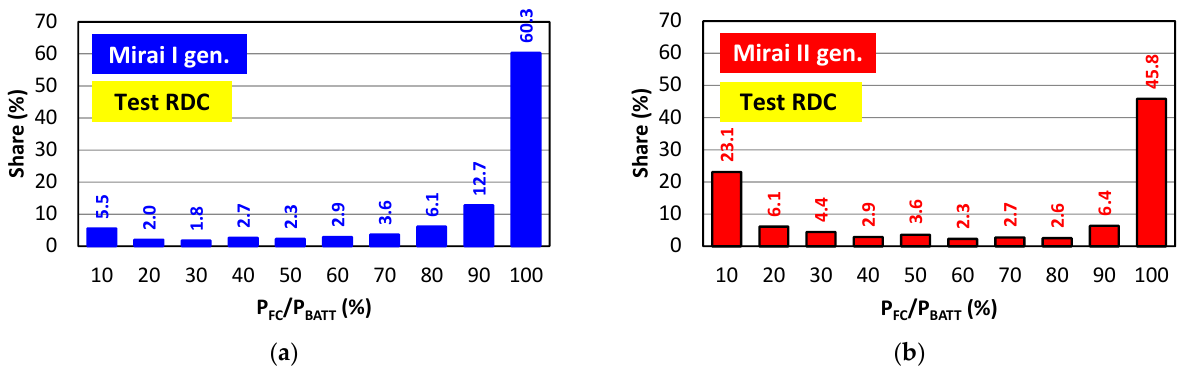
Figure 13. Fuel cell stack power and speed profiles in the RDC test: ( a ) I generation HFCHEV drive; ( b ) II generation FCHEV drive. The average fuel cell power values in the first-generation Toyota Mirai were 26% greater than the average values of the second-generation Mirai. Similarly, greater powers occurred in the rural phase of the driving test (by 35%). The motorway phase was characterized by the greater average power of the second-generation Mirai vehicle. The greater cell power was partly responsible for the observed operating conditions, but also the batteries, also with a higher power in the second generation system. Analysis of the share of the cell’s power in relation to the battery’s power was presented in Figure 14. The data analysis showed that, regardless of the fuel cell system generation, the share of their power in the entire test was the greatest at much greater power than the battery (P FC /P BATT > 90%). The second generation drive system also used a fairly large share of driving at the lowest system power, which means that the initial driving conditions could be achieved with battery drive alone. The transient conditions in which small shares of the cell’s power and high battery power were used turned out to be small. This was shown in Figure 14 in the 20–80% P FC /P BATT power ratio. Summarized, the operating conditions of cells and batteries in both drive generations were within 66– 69% of the total share of operating time. P FC /P BATT shares close to 100% do not mean the